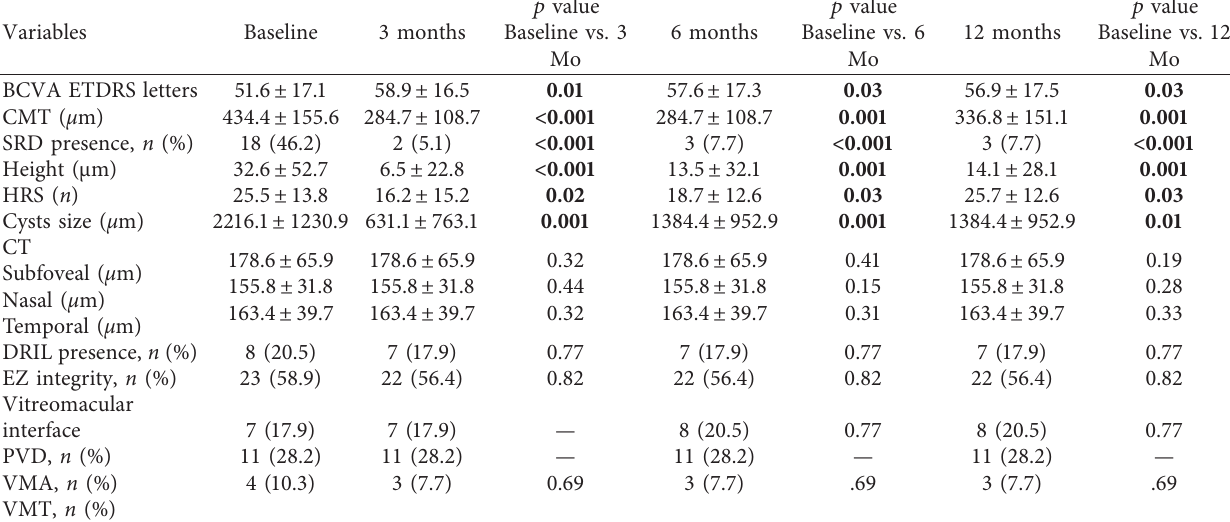
Table 2: Functional and morphological biomarkers before and after